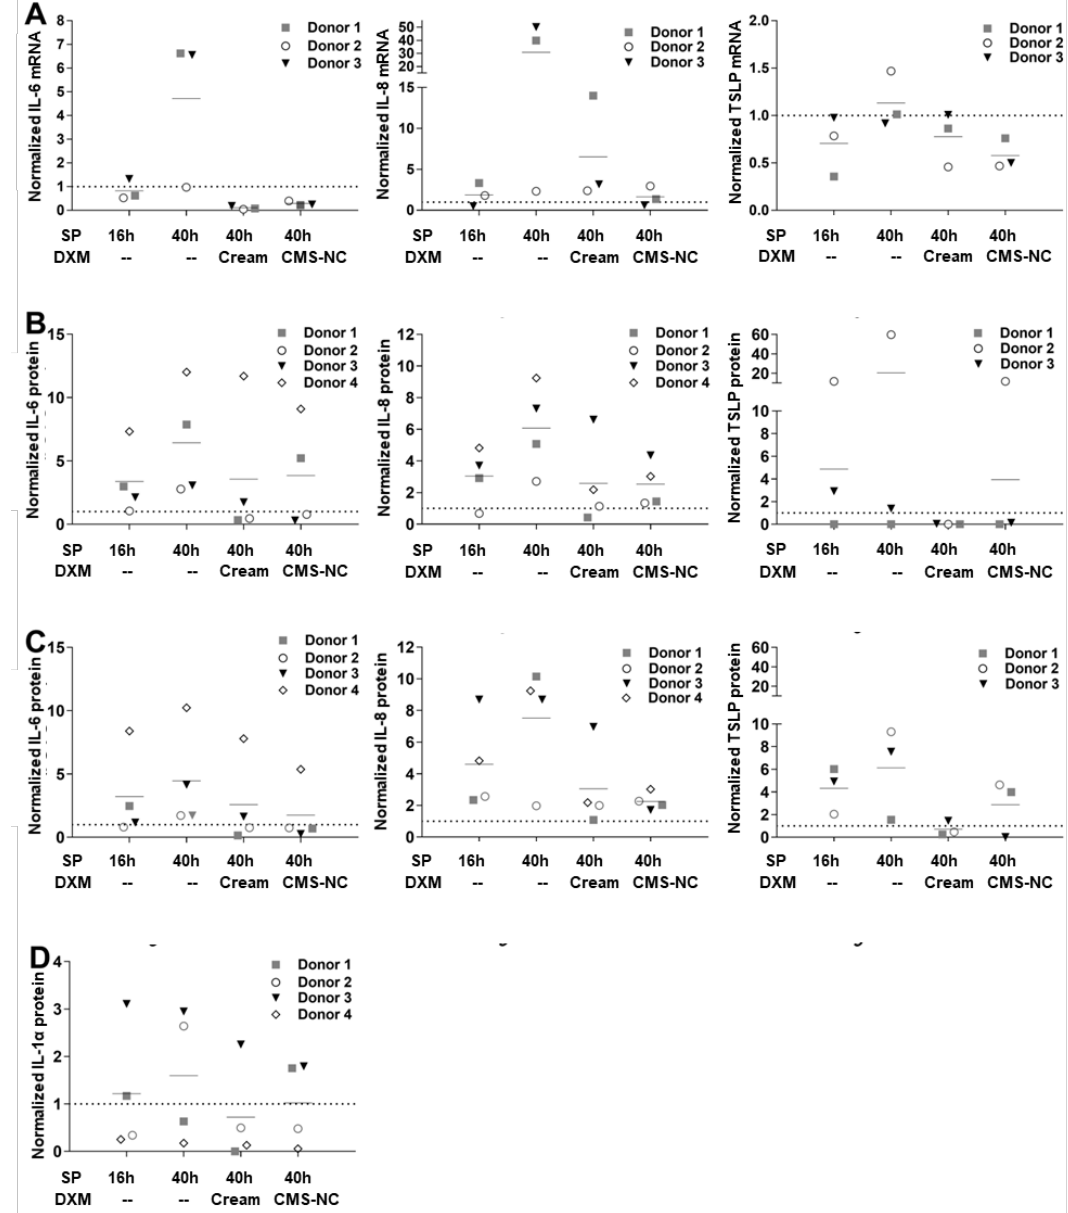
Figure 3. The relative expression of the proinflammatory markers IL-6, IL-8, TSLP and IL-1 α in ex vivo human skin after the SP treatment shows the anti-inflammatory e ff ects of DXM formulated in cream or encapsulated in CMS-NC. The mRNA and protein values were normalized to the untreated controls (non-normalized values are shown in the Supplemental Material, Figure S3). Short lines indicate the means of the di ff erent donors for each treatment group. Spotted lines indicate the expression level of the untreated controls. ( A ) mRNA expression of the investigated markers. The fold mRNA expression was first calculated with respect to the housekeeping gene hypoxanthine-guanine phosphoribosyltransferase (HPRT) and then normalized to the untreated controls. ( B – D ) Quantification of the investigated proteins in di ff erent skin layers (B = dermis, C = epidermis, D = superficial stratum corneum ) measured by ELISA. The amounts of proteins were first calculated with respect to the total protein content of each extract and then normalized to the untreated controls.